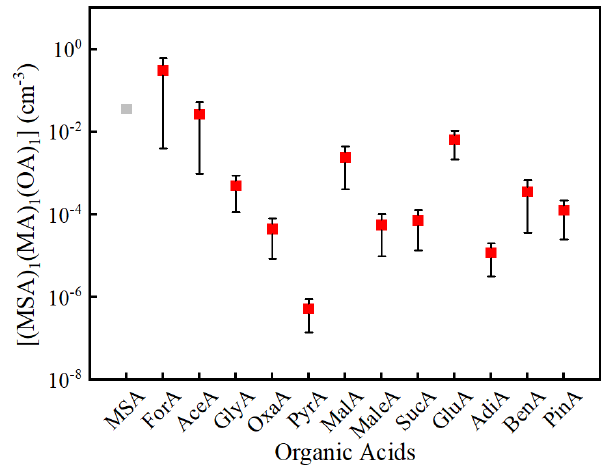
Figure 3. The calculated [(MSA) 1 (MA) 1 (OA) 1 ] and [(MSA) 2 (MA) 1 ] (moleculescm − 3 ) based on the mass bal- ance equation and reported concentrations of precursors. The bars denote the minimum and the maximum of [(MSA) 1 (MA) 1 (OA) 1 ], the red square denotes the mean values, and the gray square denotes [(MSA) 2 (MA) 1